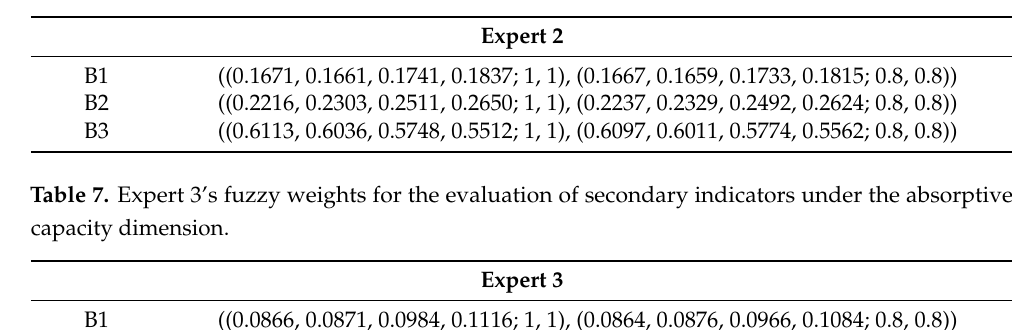
Table 6. Expert 2’s fuzzy weights for the evaluation of secondary indicators under the absorptive capacity dimension.